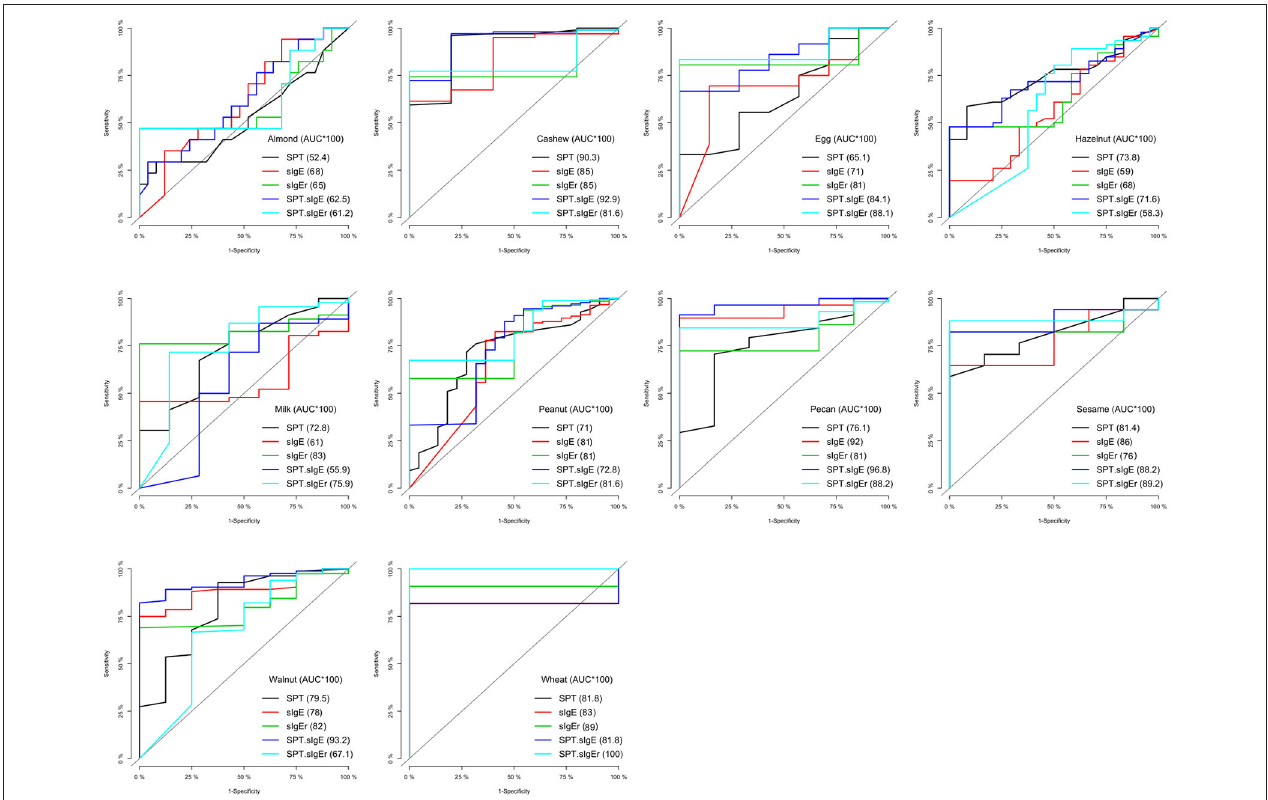
FIGURE 3 | Logistic ROC comparisons of biomarker thresholds by allergen. Comparison of each biomarker to discriminate food challenge outcome. Higher area under the curve (AUC) suggests better discriminative ability. SPT, skin prick test; sIgE, specific Immunoglobin E, sIgEr, ratio of sIgE to total